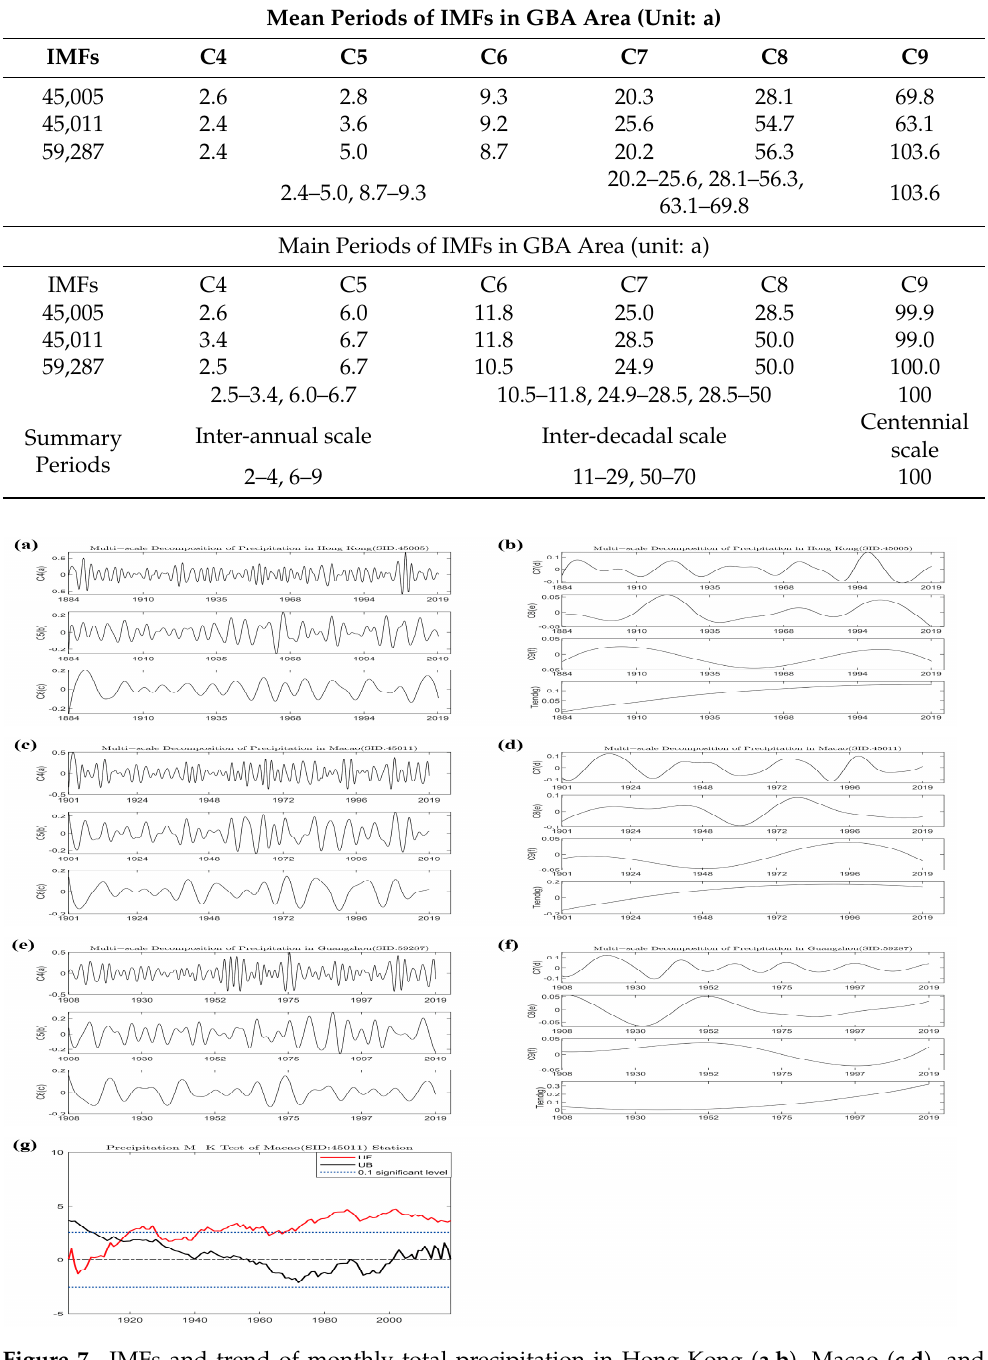
Figure 7. IMFs and trend of monthly total precipitation in Hong Kong ( a , b ), Macao ( c , d ), and Guangzhou station ( e , f ) and precipitation M-K test of Macao station ( g ).